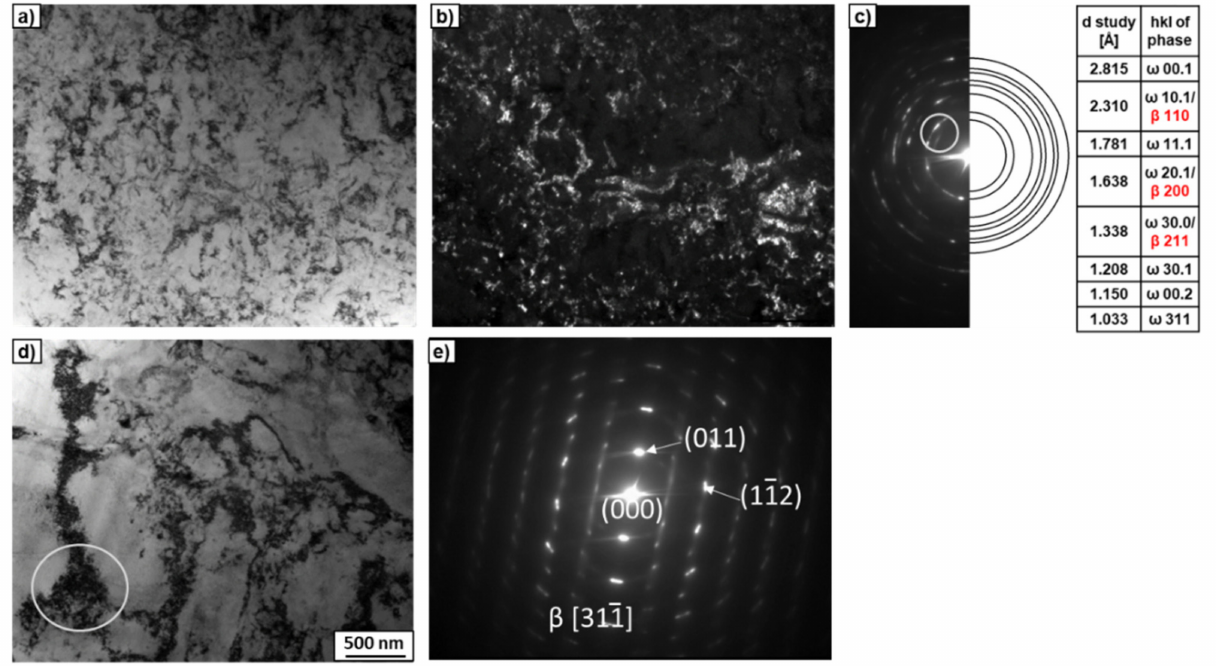
Figure 10. TEM micrographs of the Ti–18wt.% Mo after HPT. Bright-field image ( a ) and dark-field image ( b ) with the SAED pattern ( c ). The ring in the SAED pattern ( c ) indicates the position of the objective aperture for obtaining the dark-field image. The white circle marked in ( d ) shows the area from which the SAED pattern ( e ) was